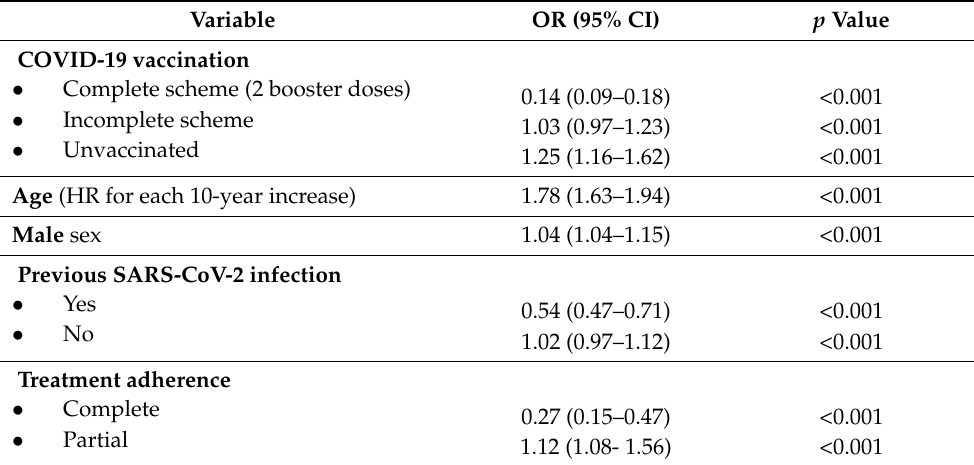
Table 5. Logistic Regression Analysis for the efficacy of treatment with nirmatrelvir/ritonavir (prevention of hospitalization/intubation/death) based on treatment adherence (n = 200 Group A, partial compliance n =